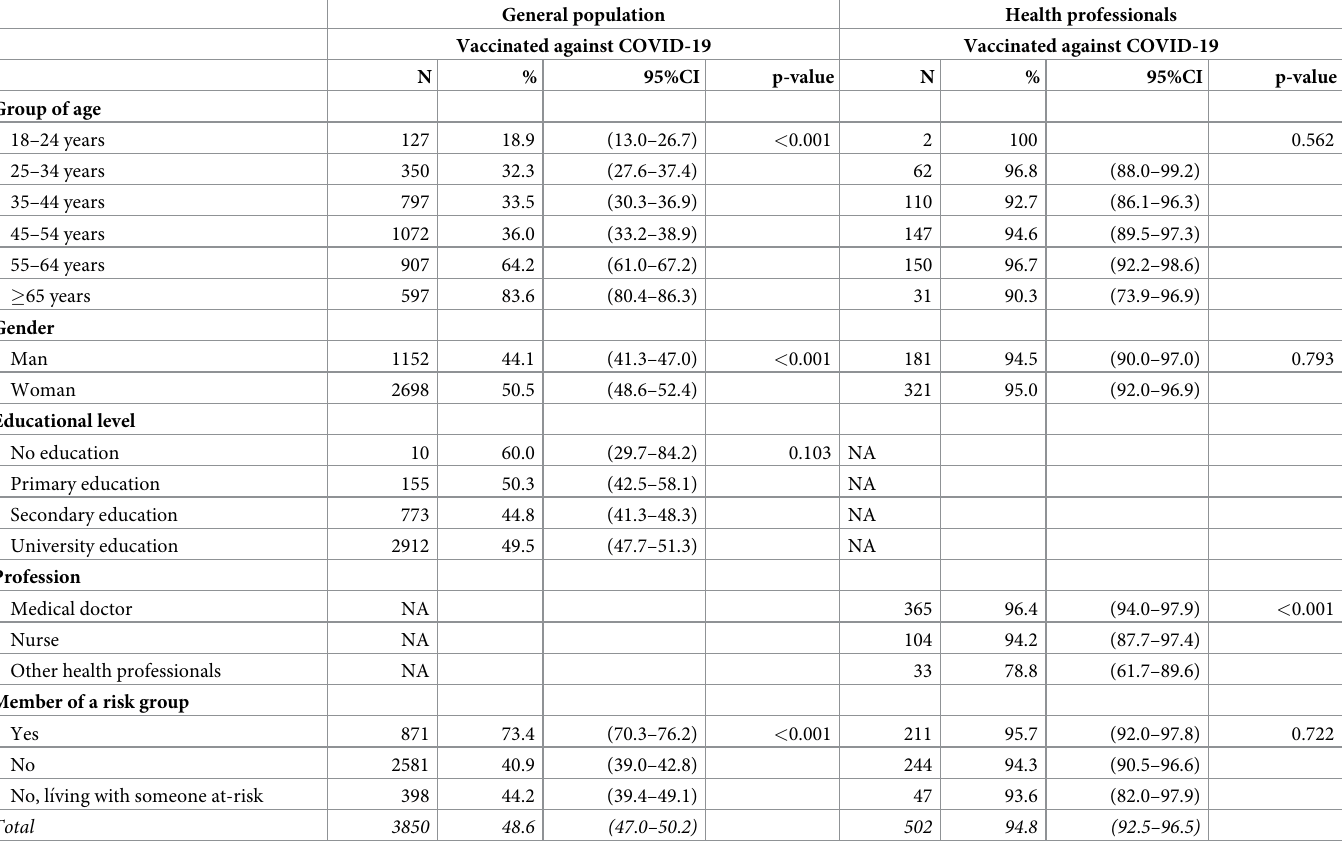
Table 2. Prevalence of vaccination against COVID-19 depending on sociodemographic and health